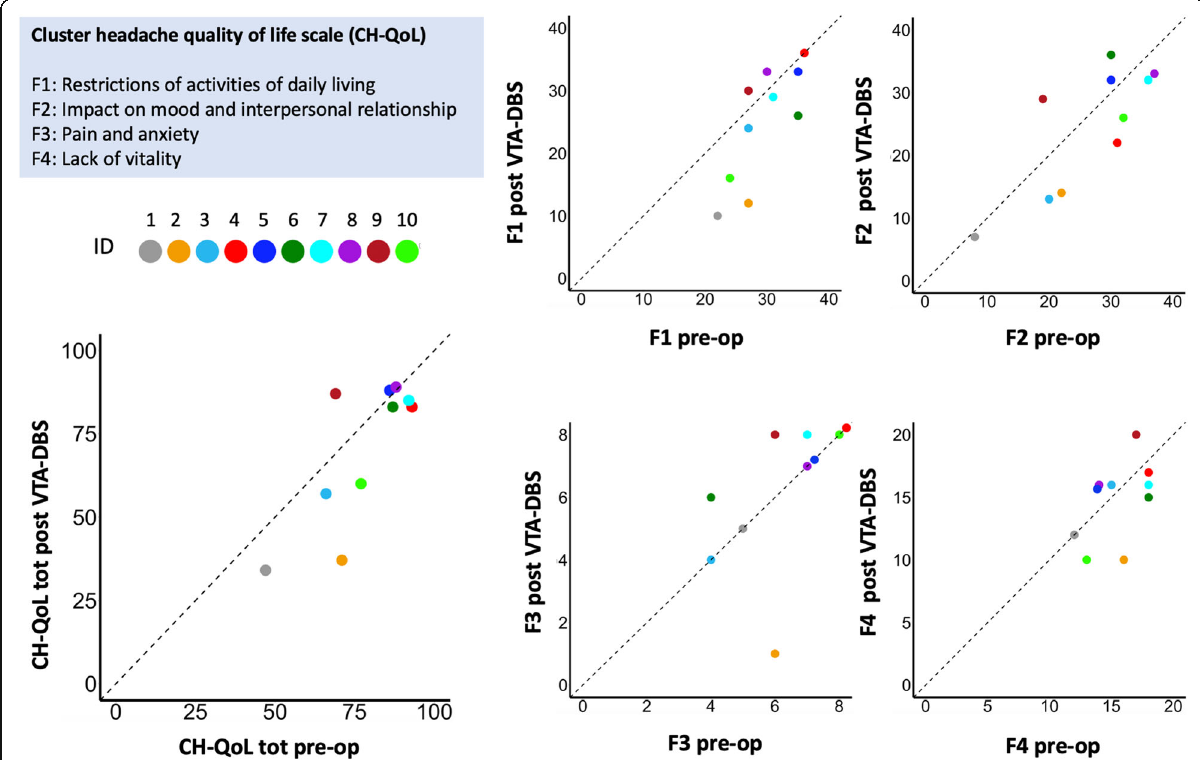
Fig. 1 Scatter plots depicting changes in CH-QoL scale total score and 4 sub-scores. Diagonal line represents x equal to y or before equal to after VTA-DBS, points that fall under the diagonal line depict a reduction in CH-QoL scale score after VTA-DBS treatment. Note: Lower scores on CH- QoL indicate better health related quality of life. CH-QoL cluster headache quality of life scale, DBS deep brain stimulation, F factors of the